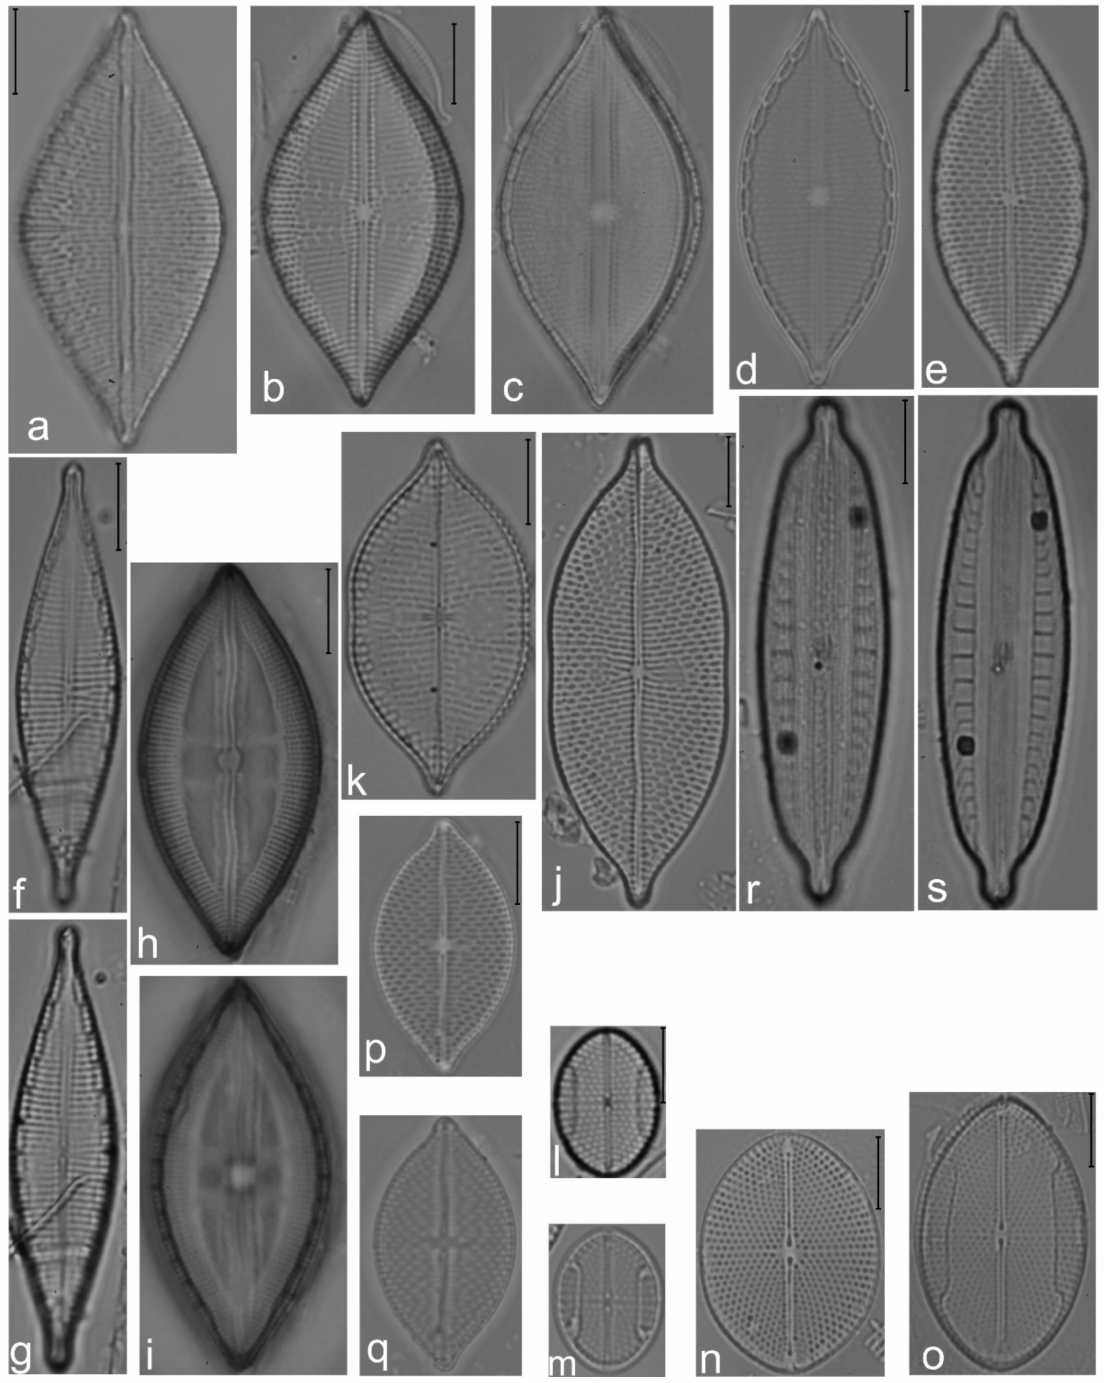
Figure 22. ( a – c ) Mastogloia beaufortiana ; ( d , e ) M . delicatissima ; ( f , g ) M . angusta ; ( h , i ) M . jelinekii ; ( j , k ) M . rostellata ; ( l – o ) M . binotata in different focal planes and showing a range in size; ( p , q ) M . lacrimata ; ( r , s ) M . similis . Scale bar = 10 µ